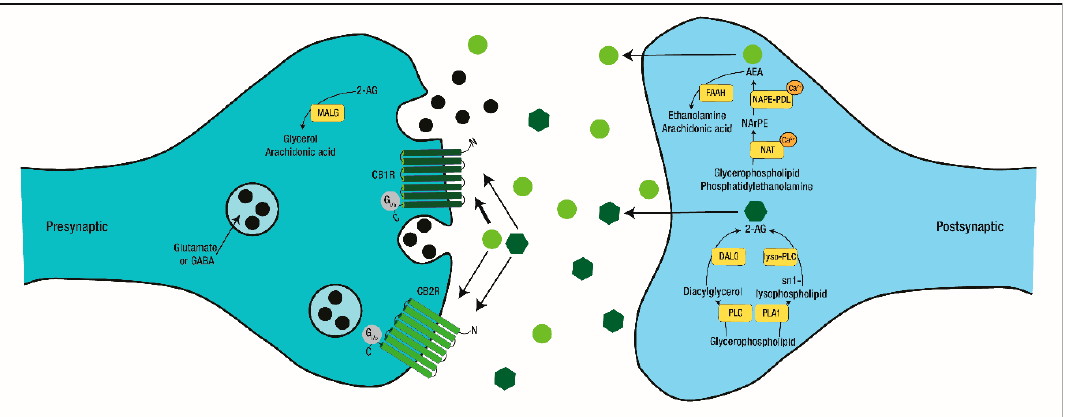
Figure 3. Pharmacology of Endocannabinoids. Anandamide (AEA) and 2-arachidonoglycerol (2-AG) are lipid-based neurotransmitters mainly synthesized postsynaptically and released “on demand” to the synaptic cleft, where they bind to the cannabinoid receptors (CB1R and CB2R) to modulate synaptic transmission.